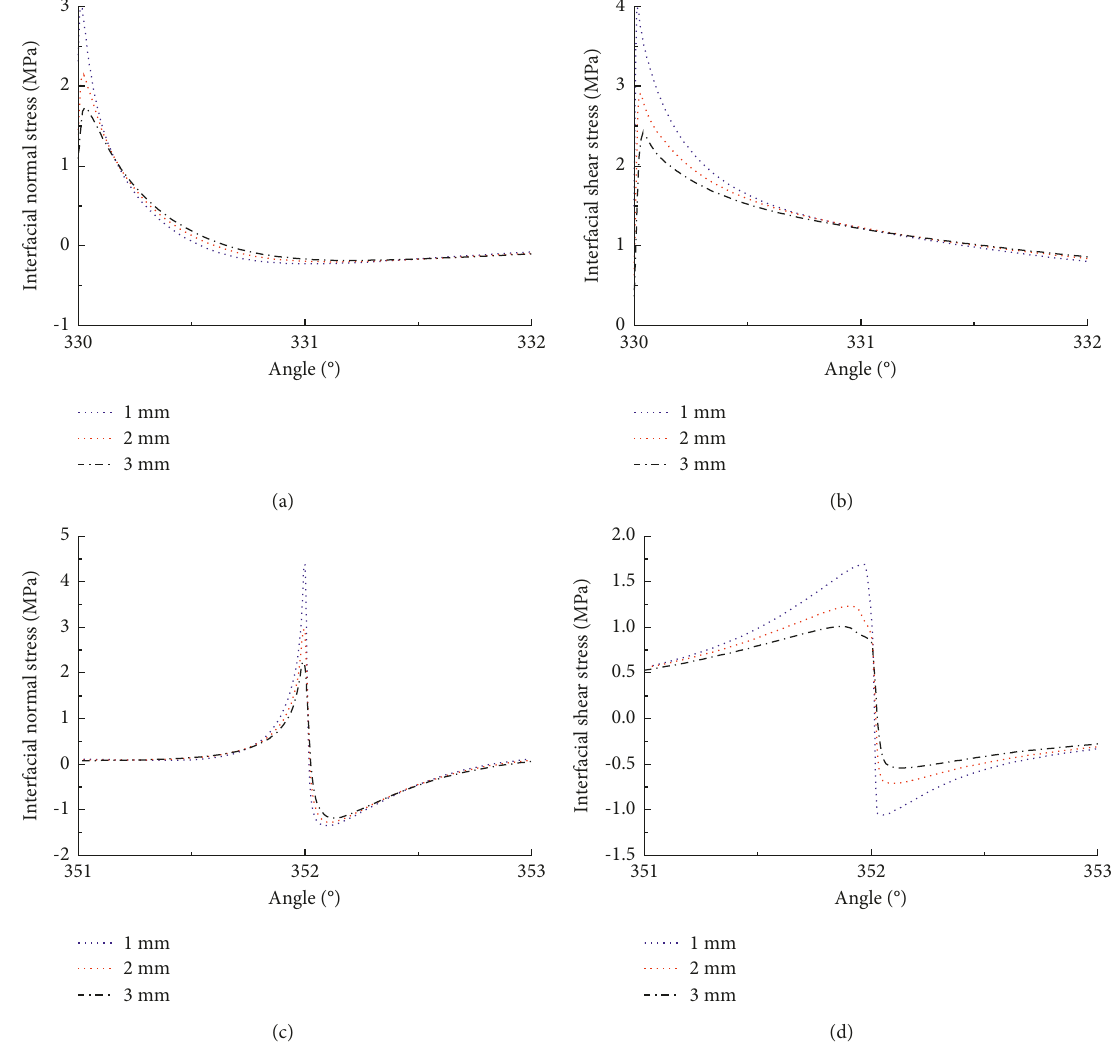
Figure 15: Interfacial stresses under adhesive layers with different thicknesses. (a) Normal stress at plate end. (b) Shear stress at plate end. (c) Normal stress at 352 ° joint. (d) Shear stress at 352 °